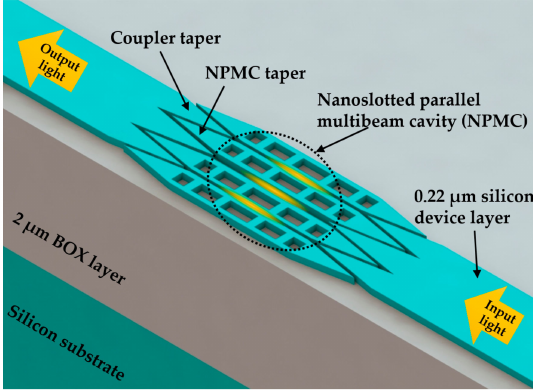
Figure 7. Nanoslotted parallel quadra-beam